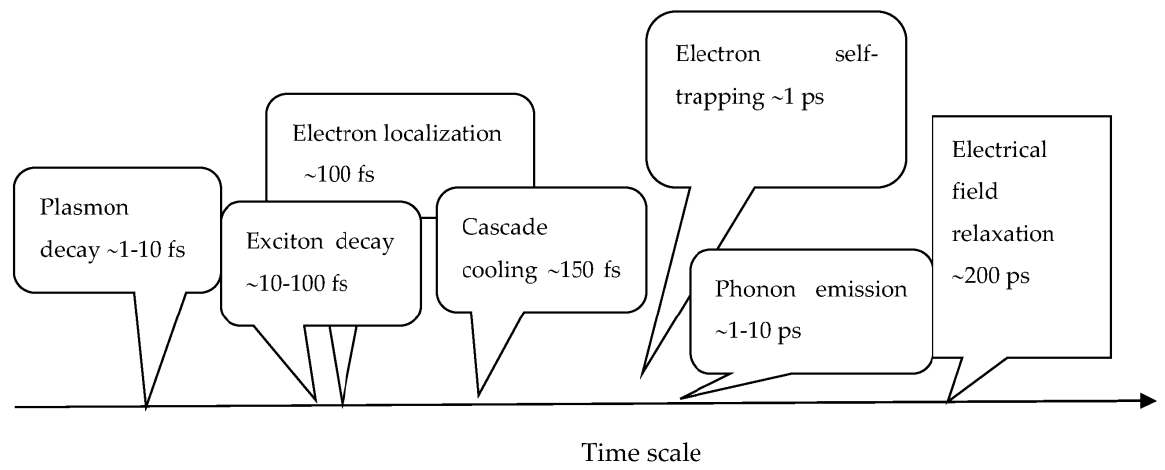
Figure 4. Schematic time scale of the various electronic processes in water ice.